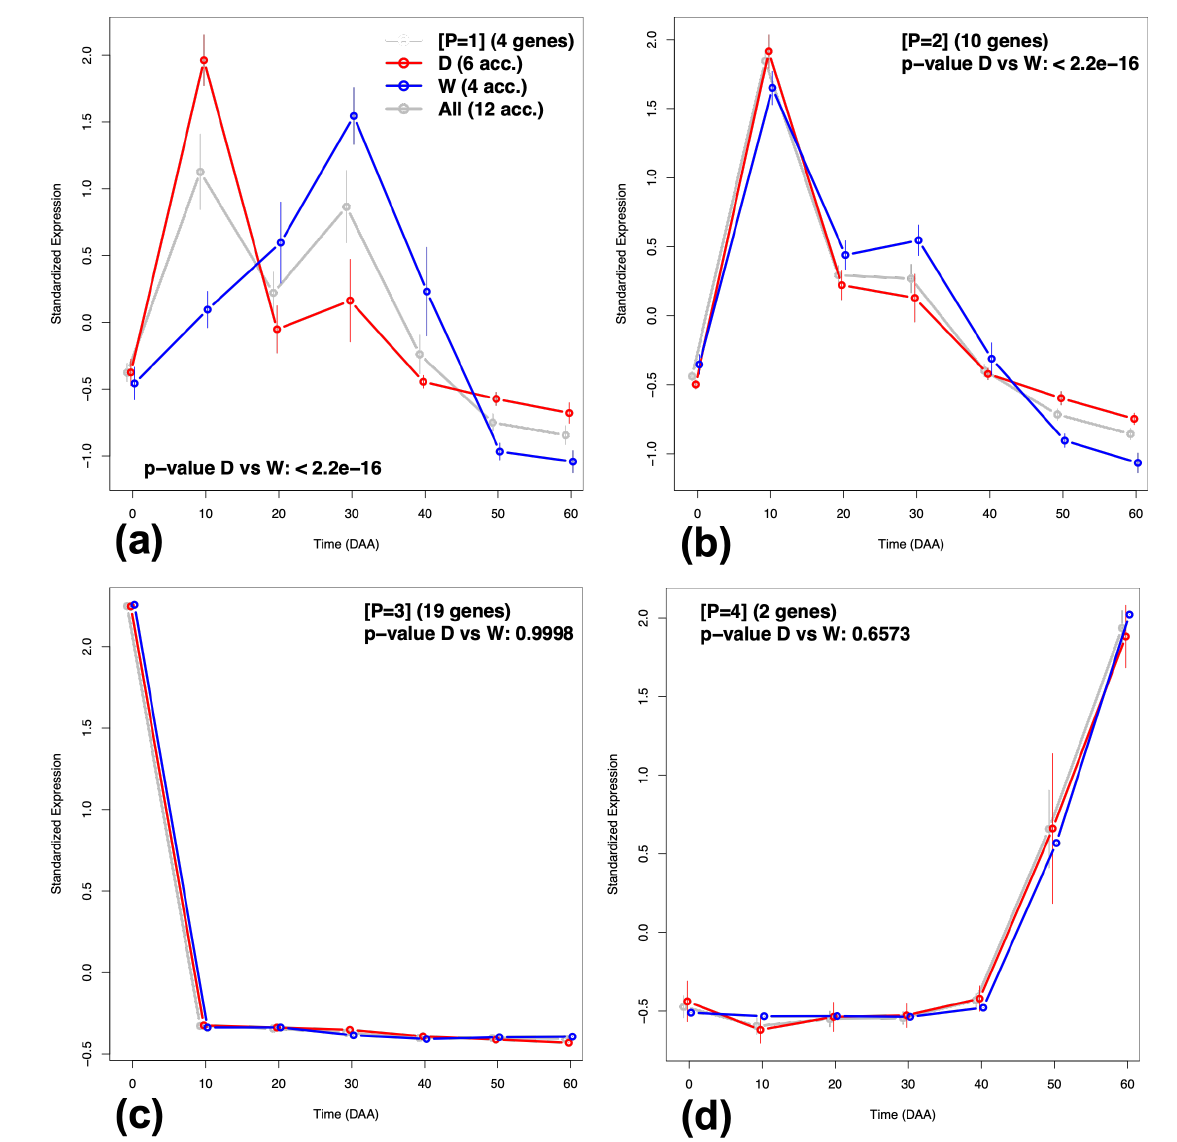
Figure 7. Average Standardized Expression Profiles (SEPs) patterns for genes included in the Meta- Network in Figure 6. ( a ) Pattern [P = 1] . ( b ) Pattern [P = 2] . ( c ) Pattern [P = 3] . ( d ) Pattern [P = 4]